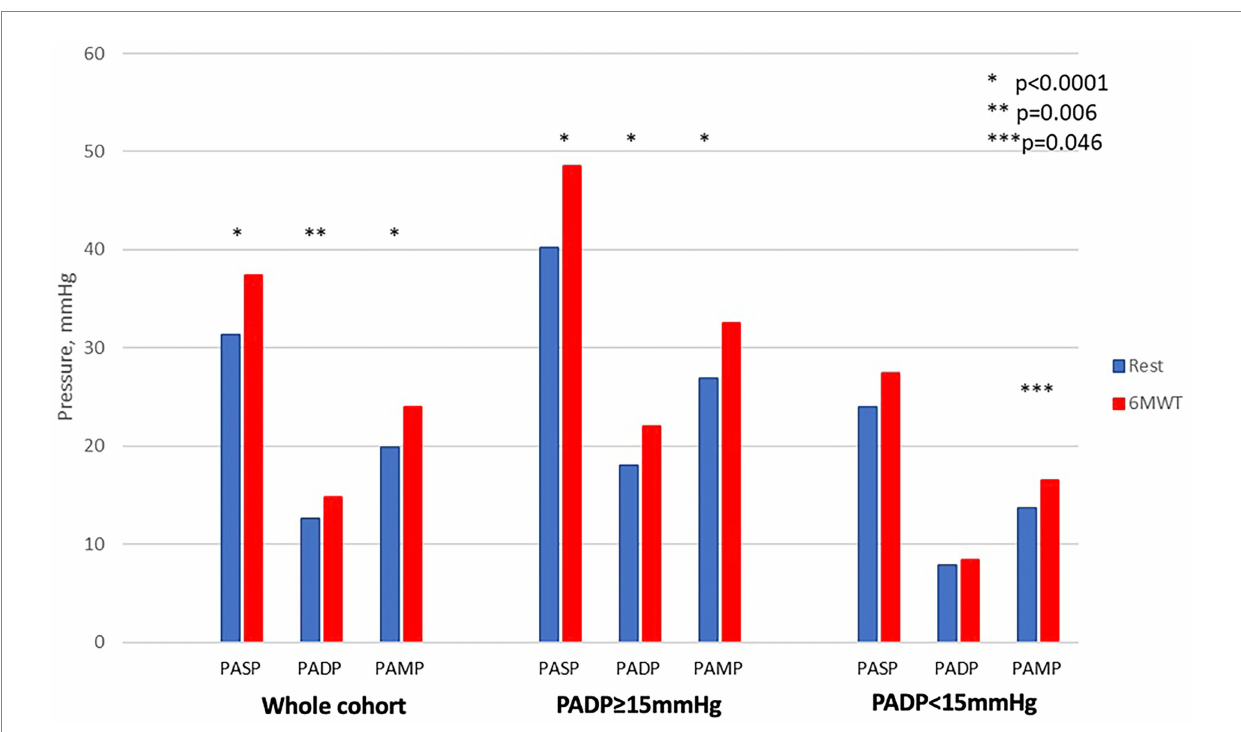
FIGURE 2 Changes in pulmonary pressures from resting supine to post-exercise in the whole cohort and in subgroups with elevated and normal pulmonary artery diastolic pressure in the supine